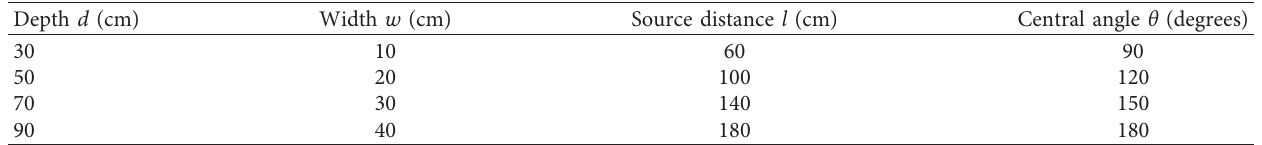
Figure 3: Test layout. Table 3: Schedule of parameters for the annular